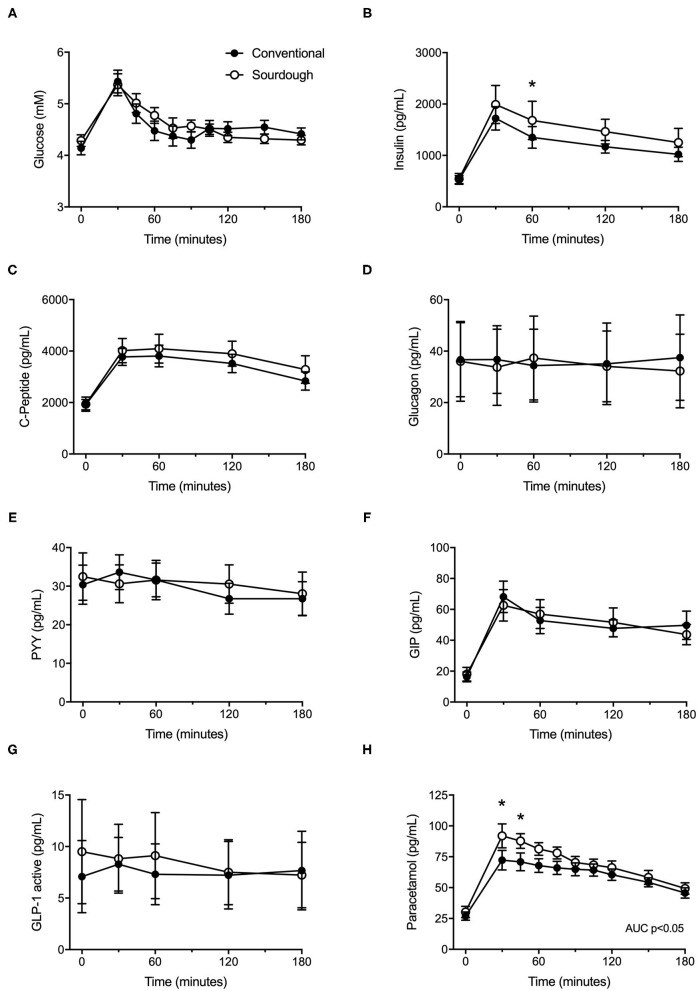
Effect of acute intake of conventional and sourdough pasta on, (A) blood glucose, (B) insulin, (C) C-peptide, (D) Glucagon, (E) PYY, (F) GLP-1, (F) GIP and (H) paracetamol. All data are presented as mean ± SEM (n = 18). Abbreviations: GIP – gastric inhibitory polypeptide, GLP1 – glucagon-like peptide, PYY – peptide YY. *Indicates statistical significance (p < 0.05) compared to conventional pasta treatment at a corresponding time point.